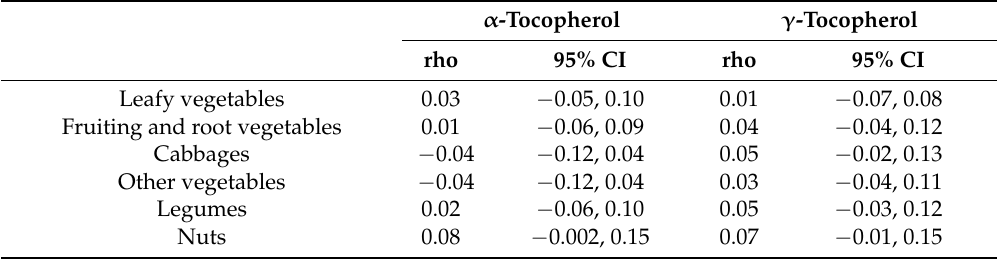
Table 3. Correlations of vitamin E rich food groups and estimated vitamin E intake from food frequency questionnaire (FFQ) with plasma vitamin E adjusted for age, sex, and total energy